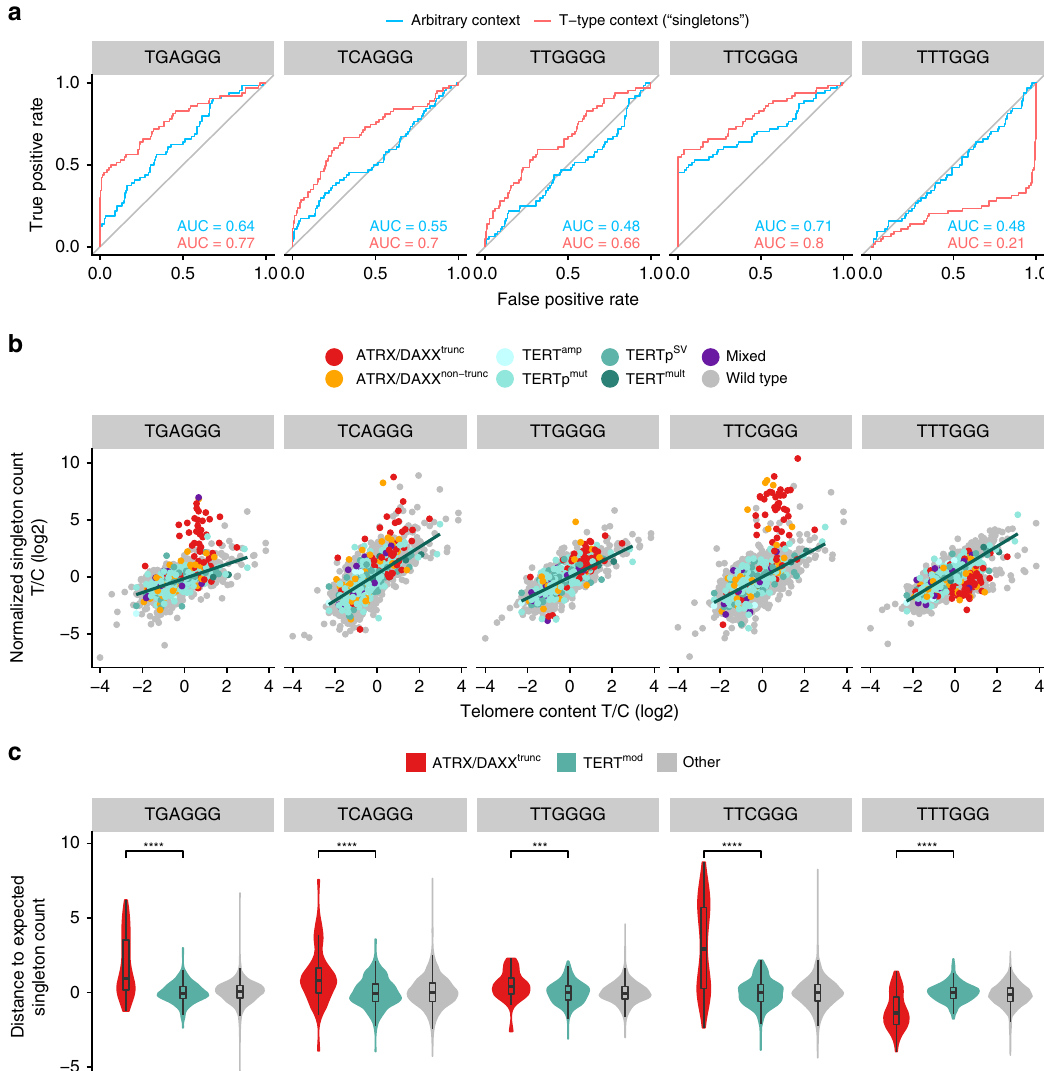
Fig. 4 Singleton TVRs enriched or depleted in ATRX/DAXX trunc samples. a Receiver operating characteristic for the classi fi cation of samples with ALT- associated mutations from telomere variant repeats. Red: no speci fi c sequence context required. Blue: singletons ((TTAGGG) 3 -NNNGGG-(TTAGGG) 3 ). The more the area under the curve (AUC) deviates from 0.5, the better the repeat occurrence distinguishes ATRX/DAXX trunc from TERT mod samples. b Pattern count tumor/control log2 ratios of all patients plotted against telomere content tumor/control log2 ratios for selected singletons. The regression line through the TERT mod samples is shown in green and is de fi ned as the expected pattern count in the following. c Distance to the expected singleton repeat count in ATRX/DAXX trunc and TERT mod samples. The center line of the boxplot is the median, the bounds of the box represent the fi rst and third quartiles, the upper and lower whiskers extend from the hinge to the largest or smallest value, respectively, no further than 1.5 × IQR from the hinge (where IQR is the interquartile range, or distance between the fi rst and third quartiles). **** p < 0.0001; *** p < 0.001, Wilcoxon rank-sum tests after Bonferroni correction. The pro fi les of all analyzed patterns are shown in Supplementary Figs. 11 and